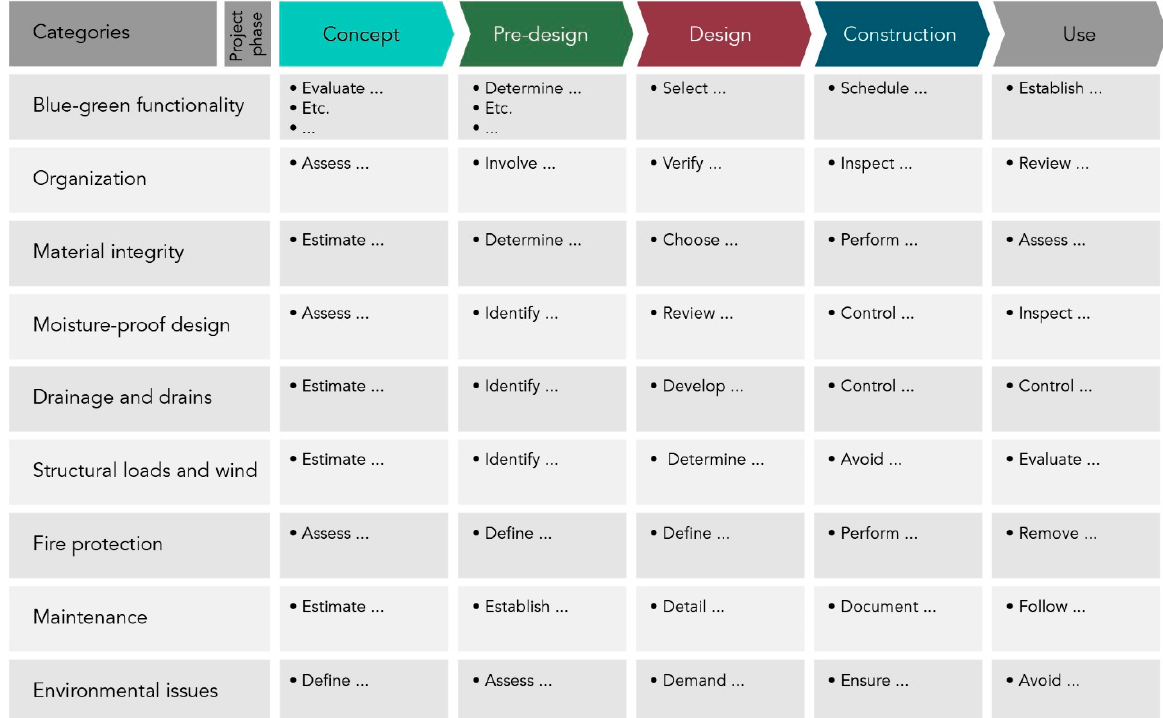
10 of 24 Figure 3. Overview of risk elements for green and blue-green roofs. Main details susceptible to defects are circled. They are, from left to right: flashings along the top of parapets, transitions between parapet and roof, drains, areas of high traffic, mounting systems for technical equipment, and transitions between the roof and adjoining walls, including doors. 4.2. Outline of the Risk Reduction Framework